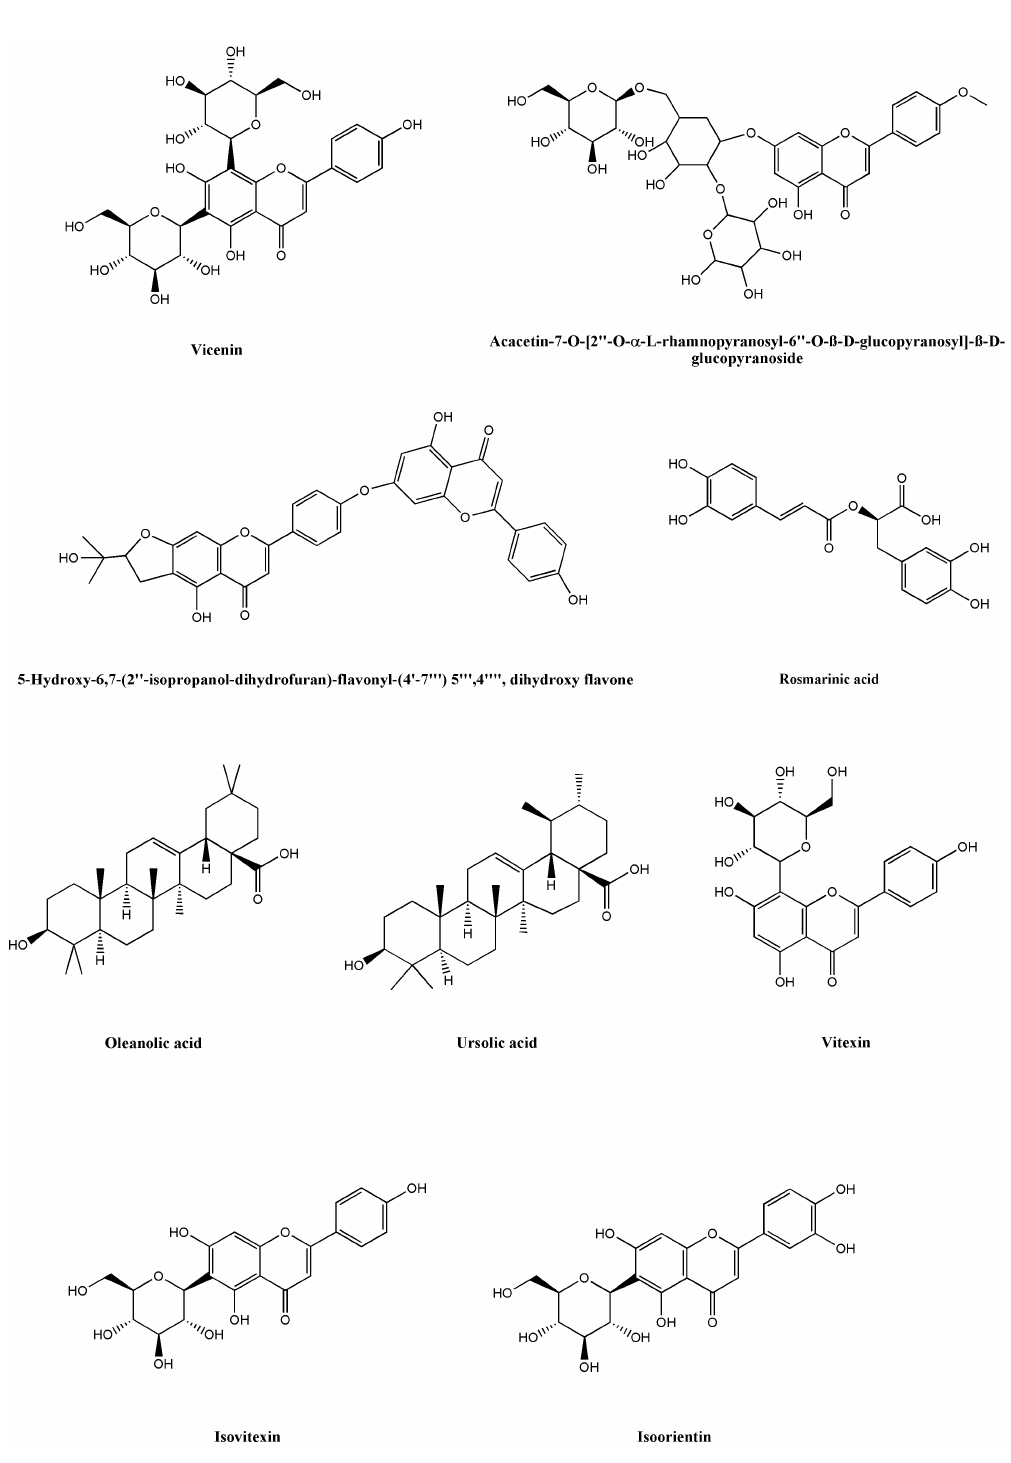
Figure 1. Major phytochemical components of Origanum Syriacum extracts. ( A ): Aqueous, ( B ): Ethanolic, and ( C ): Methanolic extracts. Table 1. Summary of phytochemical composition of Origanum Syriacum extracts.